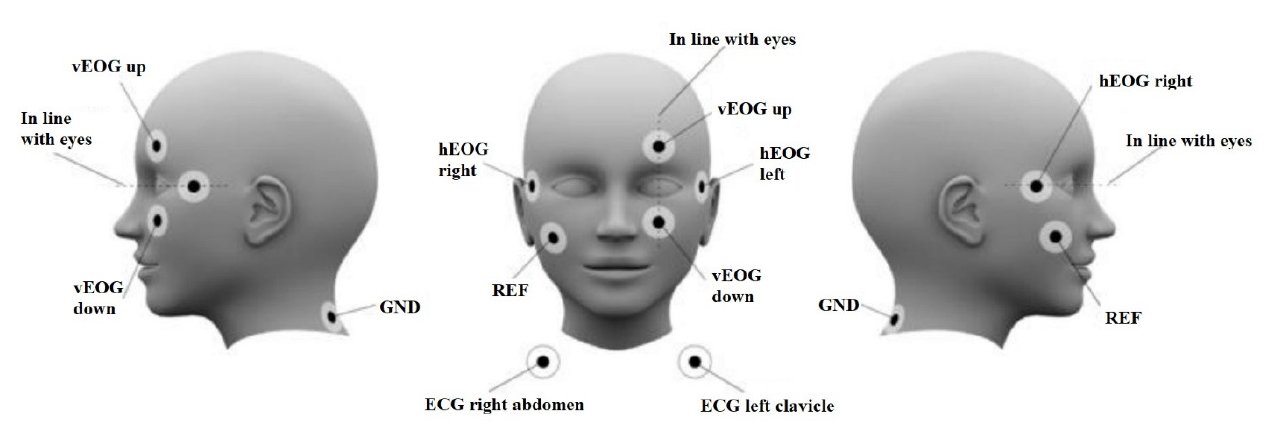
Figure 2. Placement of EOG and ECG for MEG Experiment. Reprinted from [30]. (Copyright 2017 NatMEG). Image reproduced with permission from NatMEG .